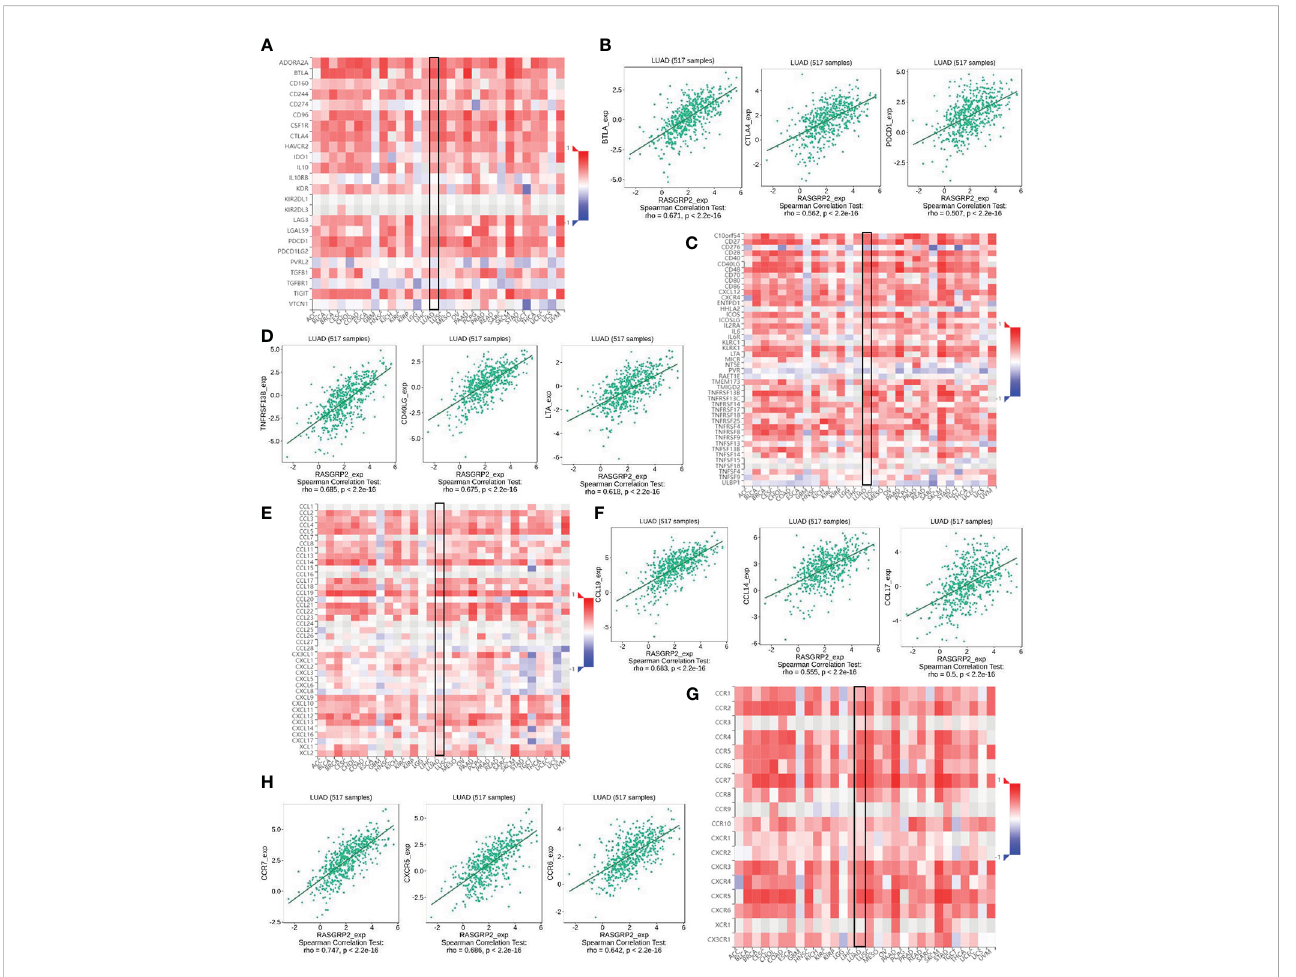
FIGURE 10 The correlation between RASGRP2 and immunoinhibitors, immunostimulators, chemokines and chemokine receptors via TISIDB analysis. (A, B) The RASGRP2 expression was positively associated with most of the immunoinhibitors. (C, D) The RASGRP2 expression was positively associated with most of the immunostimulators. (E, F) The RASGRP2 expression was positively associated with most of the chemokines. (G, H) The RASGRP2 expression was positively associated with most of the chemokine